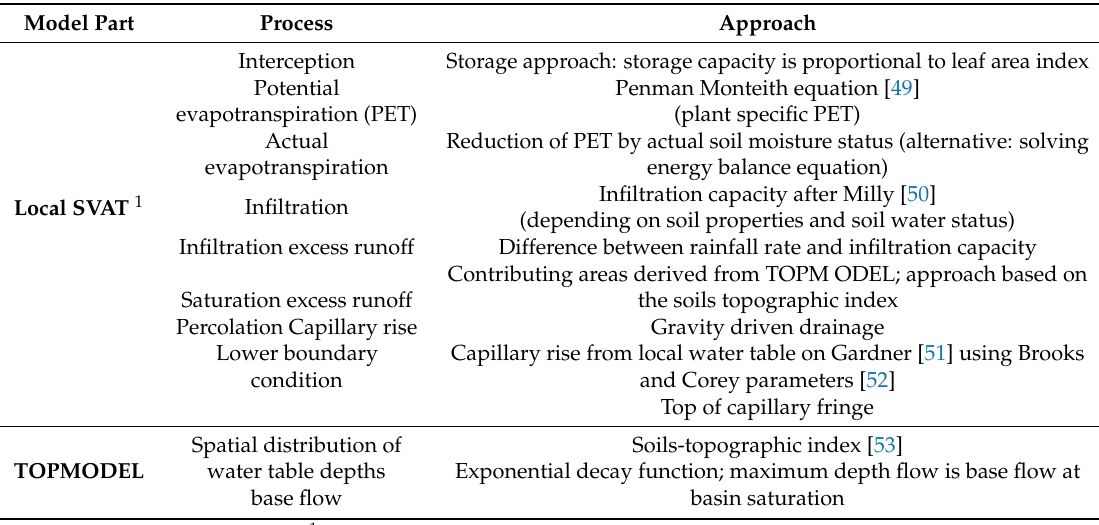
Table 2. Main processes and equations in the TOPLATS